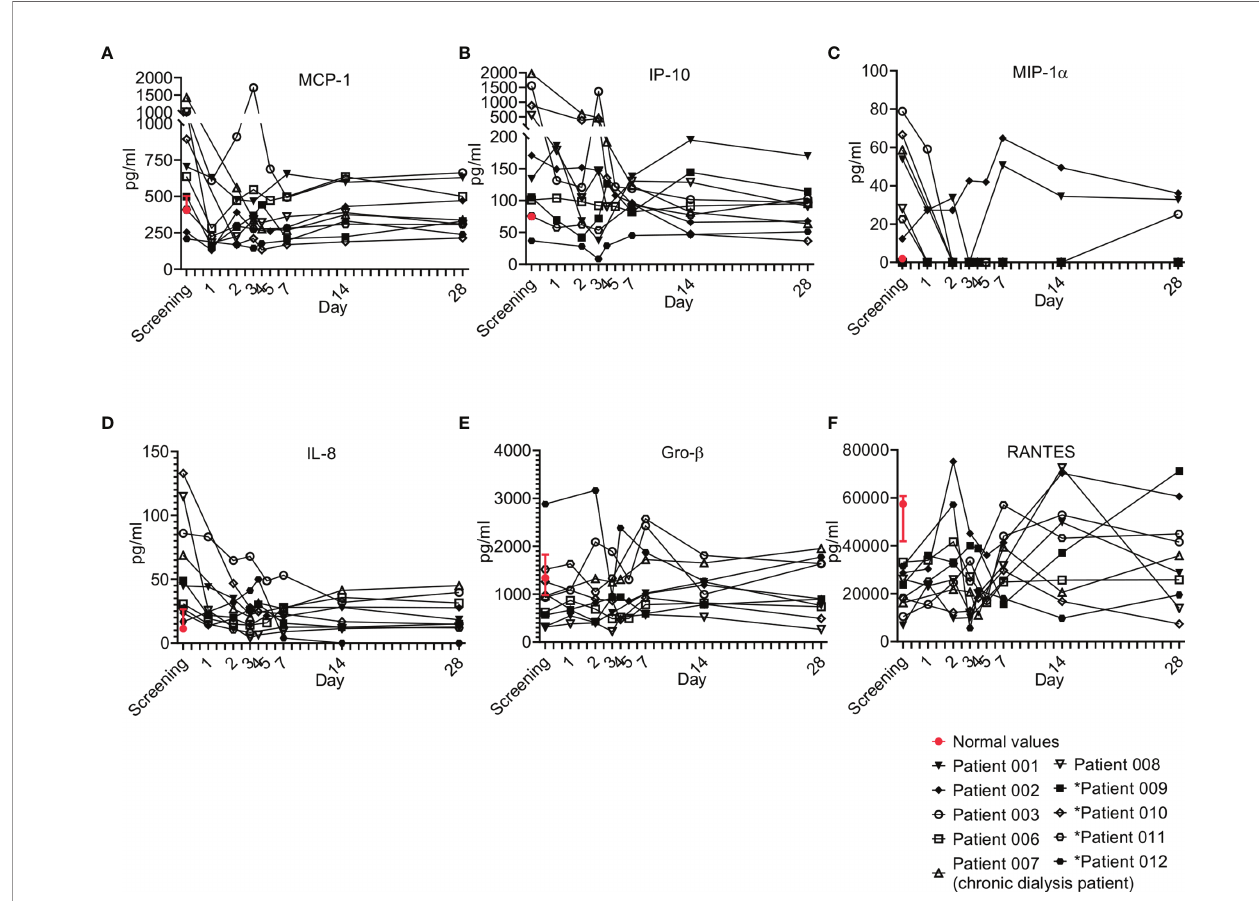
FIGURE 7 | Chemokine kinetics during sepsis. Serum was obtained from patients at the indicated times and cytokine/growth factor analysis was performed as described in Methods. The serum of three healthy volunteers was analyzed using the same methods and values are presented as the normal range (median ± range). Serum concentrations of (A) MCP-1, (B) IP-10, (C) MIP-1 a , (D) IL-8, (E) GRO- b , and (F) RANTES are presented. Patients 01 – 08 received one dose of Allocetra-OTS on day 1 and patients 09 – 12 received two doses on days 1 and